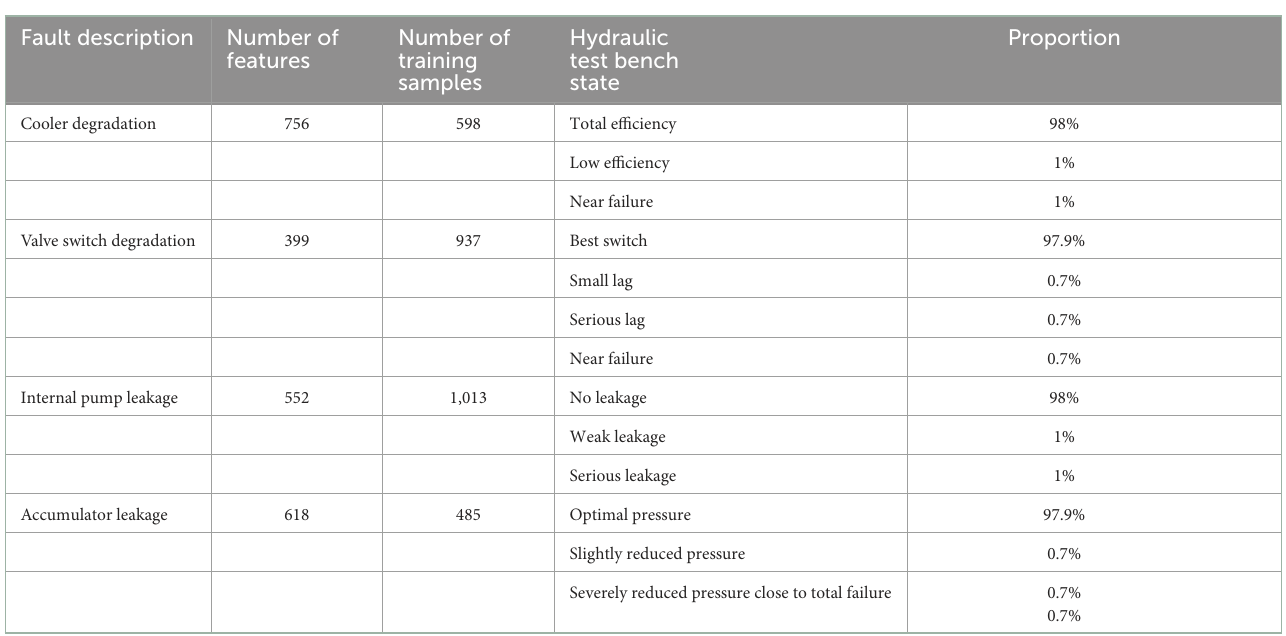
TABLE 1 Data statistics